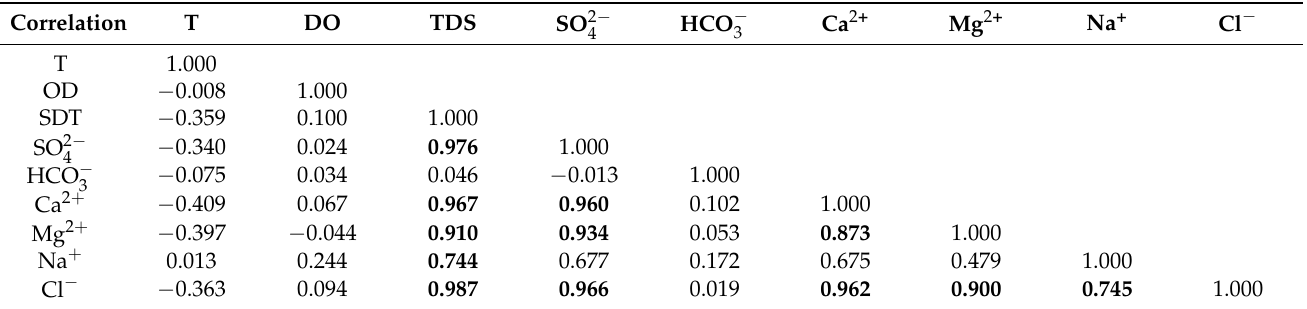
Table 2. Correlation matrix for physicochemical parameters in water sampled in 2020.